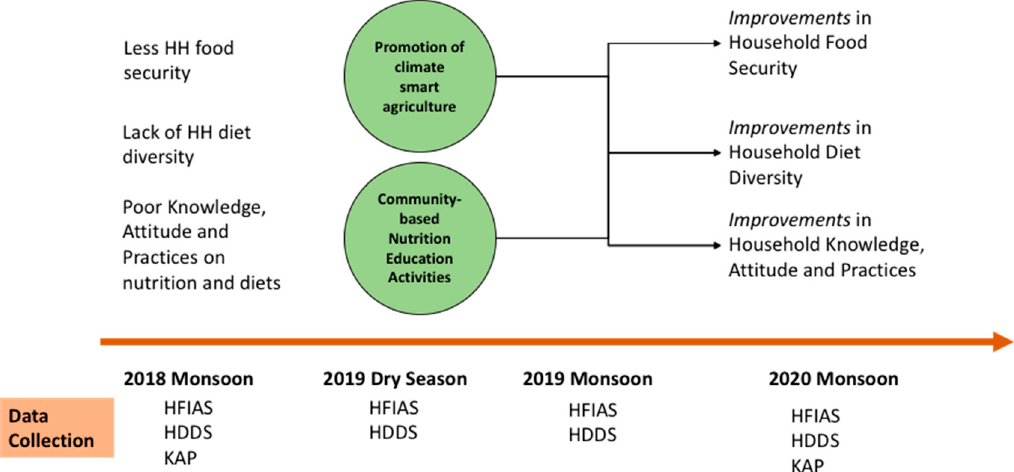
Figure 1. Conceptual framework for study. HH: household; HFIAS: Household Food Insecurity Access Scale; HDDS: Household Dietary Diversity Score; KAP: knowledge, attitudes and practices.